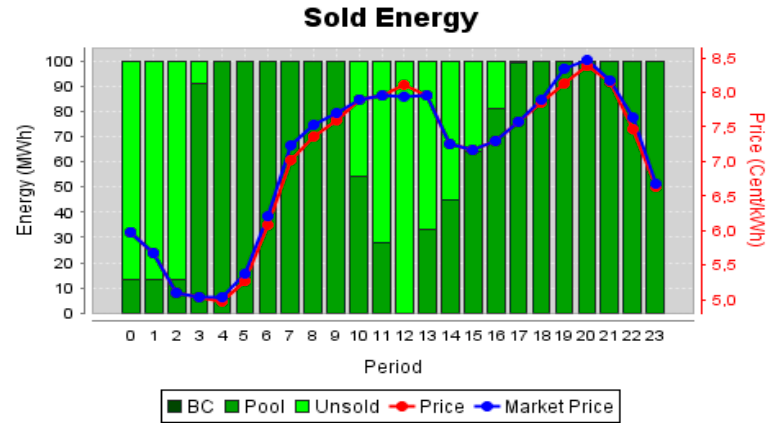
Figure8. Figure 8. Energy sold on the market when not participating in the Guarantees of Origin certificate market.